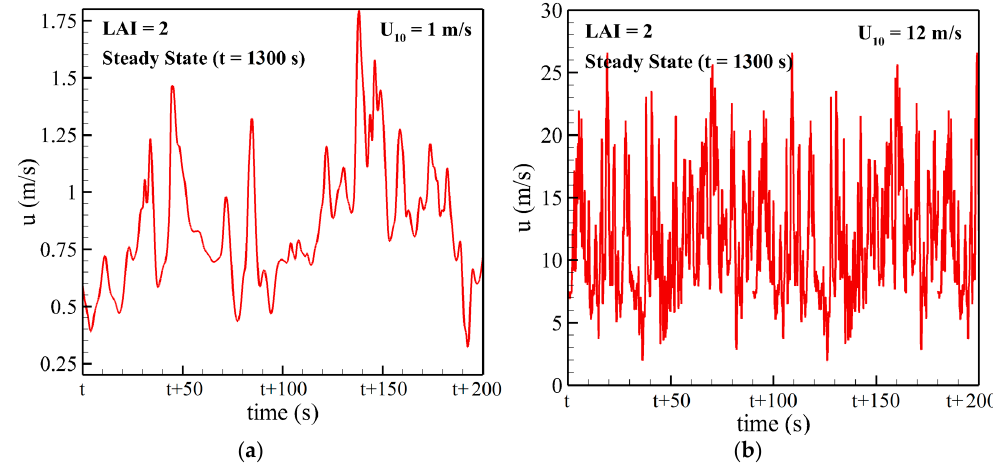
Figure 6. Time evolution of stream-wise velocity component u obtained at steady state ( t = 1300 s) at point ( x = 100 m, z = H ) for LAI = 2 and for U 10 = 1 m/s ( a ) and 12 m/s ( b ).